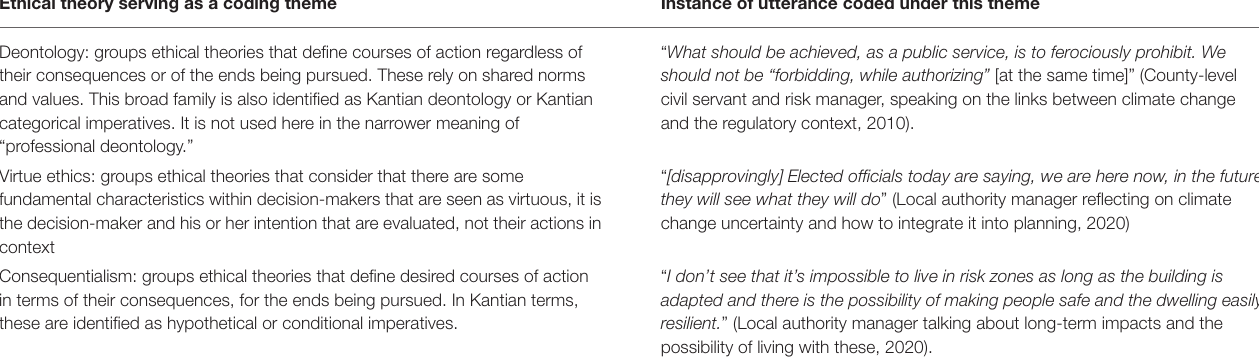
TABLE 2 | Predefined thematic coding